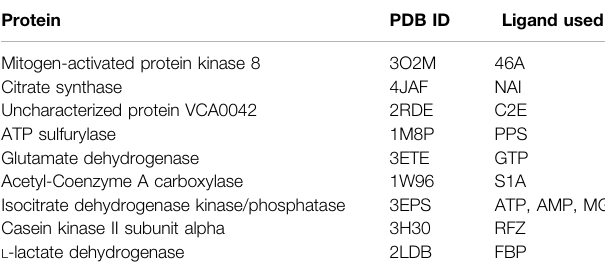
Isocitrate dehydrogenase kinase/phosphatase ( Figure 3G ), Casein kinase II subunit alpha ( Figure 3H ), and L -lactate dehydrogenase ( Figure 3I ) and colored in a simple binary way to indicate only the changes in blue showing all residues with losses fl uctuations and red for all residues showing gains in fl uctuation. Results consistently indicate increased fl uctuations in the distant regions of each protein far from the location where the ligand is bound. In ATP Sulfurylase, binding of the ligand to N-terminal region for all three chains (A, B, and C), indicating a compensatory mechanism of entropy conservation across the